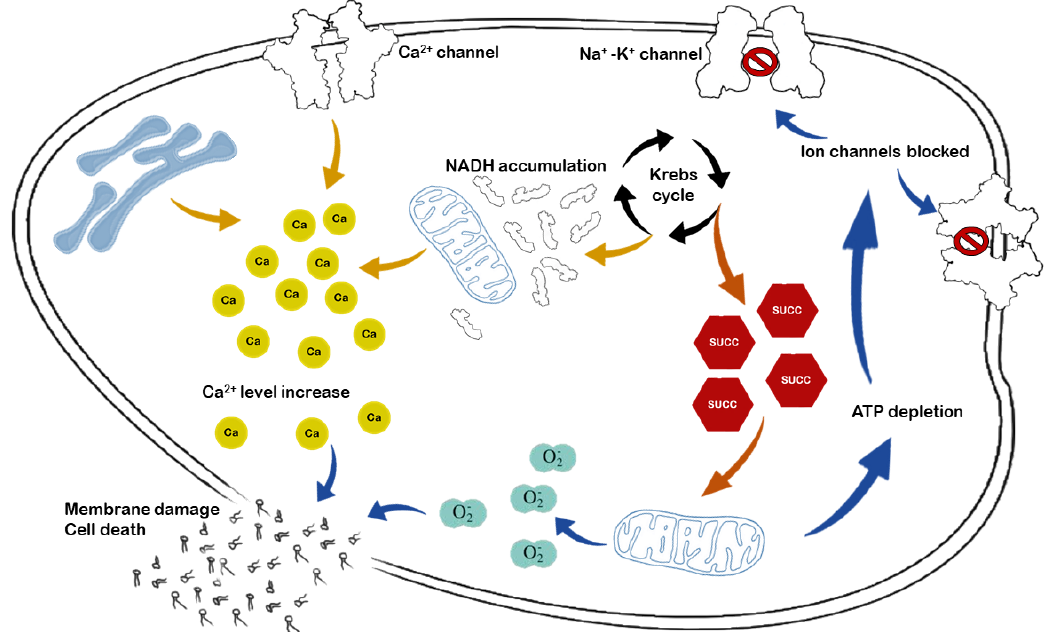
Figure 2. Intracellular mechanisms of ischemic injury are mediated mainly through ATP depletion. Oxygen deficiency results in impairment of oxidative phosphorylation and the production of reactive oxygen species (ROS), such as superoxide radicals (O 2− ). As an upstream mechanism, accumulation of succinate and NADH is responsible for increasing mitochondrial Ca 2+ flux. As regards downstream changes, inhibition of ATP-dependent Ca 2+ channels further increases intracellular Ca 2+ levels and causes membrane damage and cell death in conjunction with ROS.